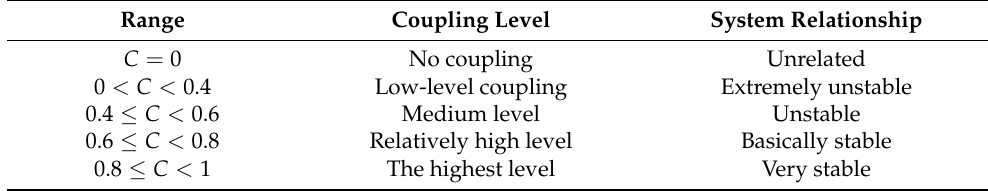
Table 3. Classification standard of coupling degree.